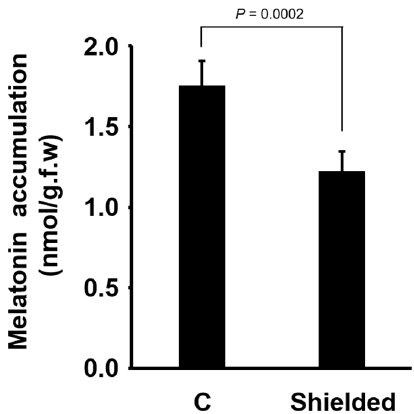
Figure 4. Melatonin accumulation in the control and shielded plants 12 h after melatonin (4 mM) application to the roots. Plants were shielded to reduce airflow. Data represent the mean ± SD ( n = 20) originated from repeated experiments. Each test was carried out with two biological replicates containing five seedlings. Statistical significance was determined using Student’s t -test.